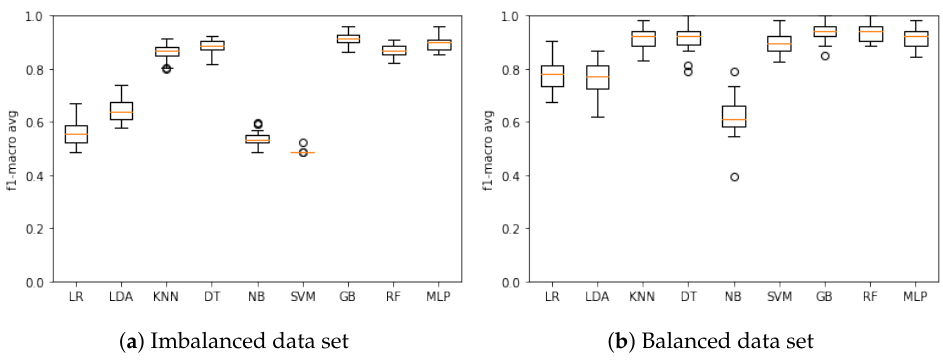
Figure 2. F1-macro results for the machine learning model training when using the ( a ) imbalanced and ( b ) balanced data set